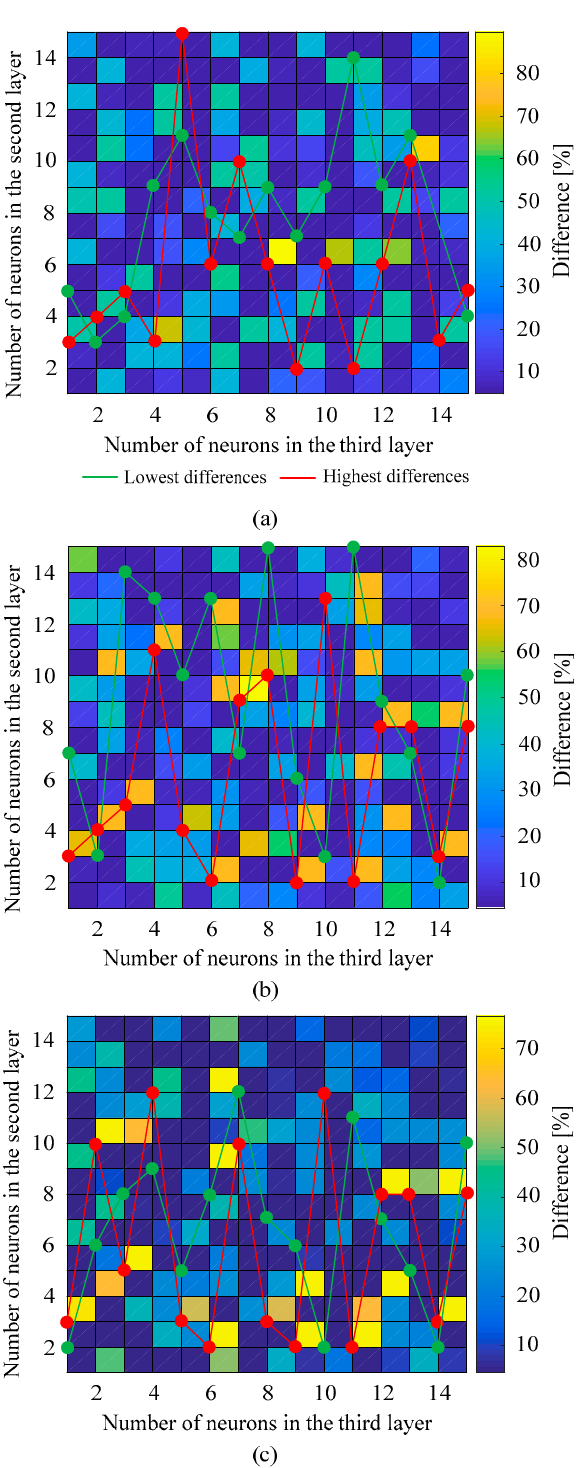
Figure 11. Relationship between the number of neurons in the hidden layers of the FFBN and the prediction results when inductivity of the helical turns was ( a ) 10 nH, ( b ) 18 nH, and ( c ) 27 nH.